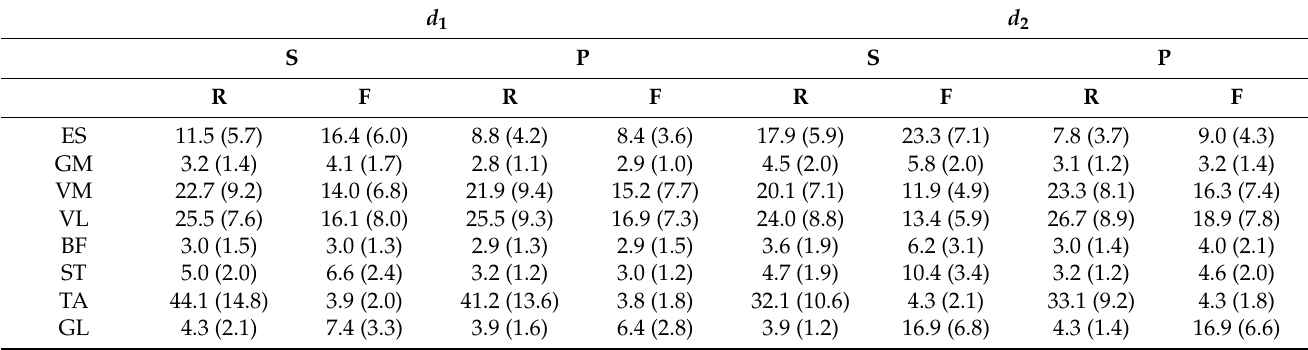
Table 4. Muscle activation levels (expressed as a percentage of the peak electromyographic amplitude at MVIC) recorded during the SBWS exercise executed with knees flexed at 45 ◦ and in two different conditions for each of the three exercise variables: (1) horizontal distance d of the ankles from the wall ( d 1 = 0.5 · l thigh and d 2 = l thigh ); (2) scapular (S) or pelvic (P) location of C wall ; (3) rearfoot (R) or forefoot (F) location of C GR . Data reported as mean (standard deviation). ES = erector spinae, GM = gluteus maximus, VM = vastus medialis, VL = vastus lateralis, BF = biceps femoris, ST = semitendinosus, GL = gastrocnemius lateralis, TA = tibialis anterior; S: C wall at the scapular zone, P: C wall at the pelvic zone, R: C GR at rearfoot, F: C GR at forefoot. d 1 d